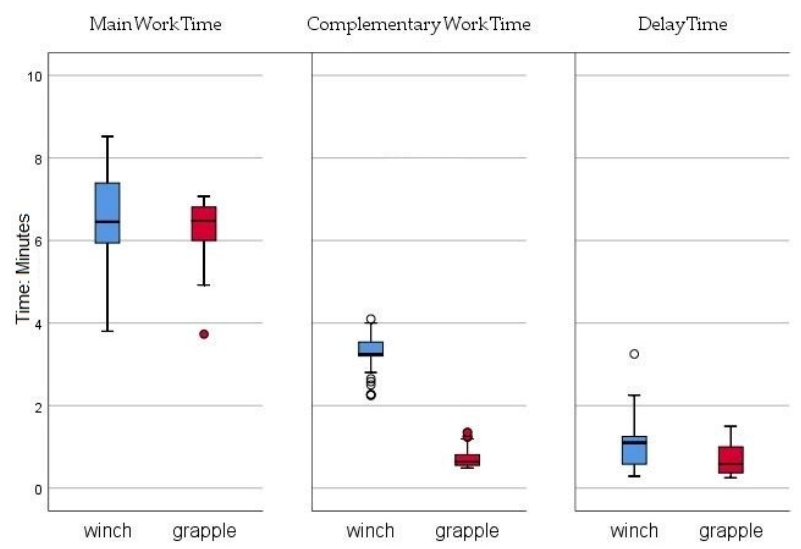
Figure 4. Time consumption of work element for scenarios (i) and (ii). The boxes include the variability of the data between the 25th and the 75th percentiles. The horizontal black line represents the median. Whiskers are the largest and smallest values that are not outliers.